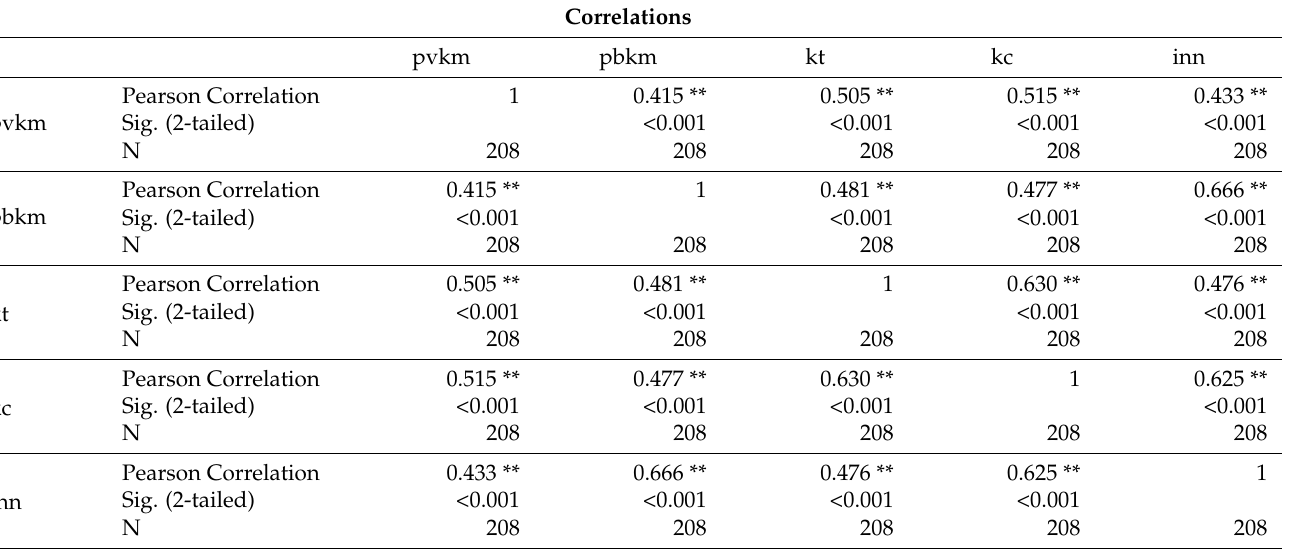
Table 4. Correlation